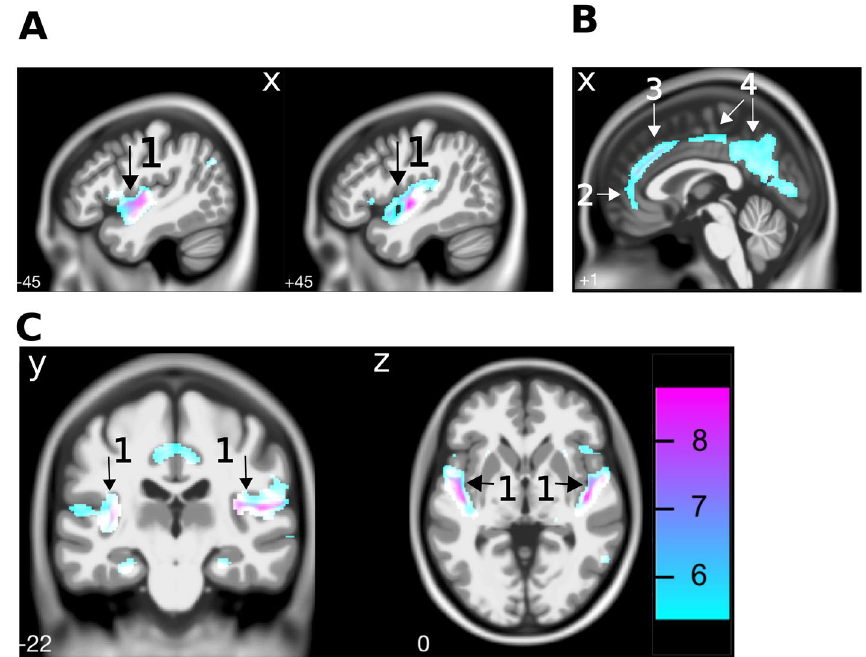
Figure 3. Cortical gray matter volume differences related to age. A multiple regression model with the covariates age, sex, tinnitus, and hearing thresholds at 2, 4, and 8 kHz indicated that increasing age was associated with less gray matter volume in (A) temporal areas (including the bilateral auditory cortices (1)) and (B) anterior (2), middle (3) and posterior (4) cingulate areas, at FWE < 0.05. Scale bar indicates T values.